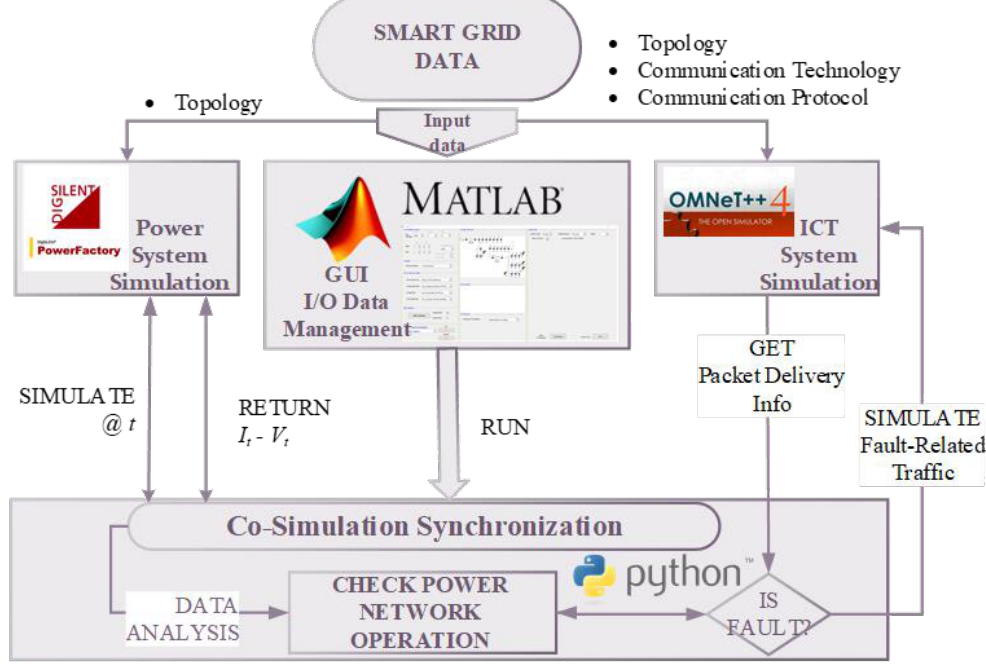
Figure 1. Schematic representation of the co-simulation tool proposed.